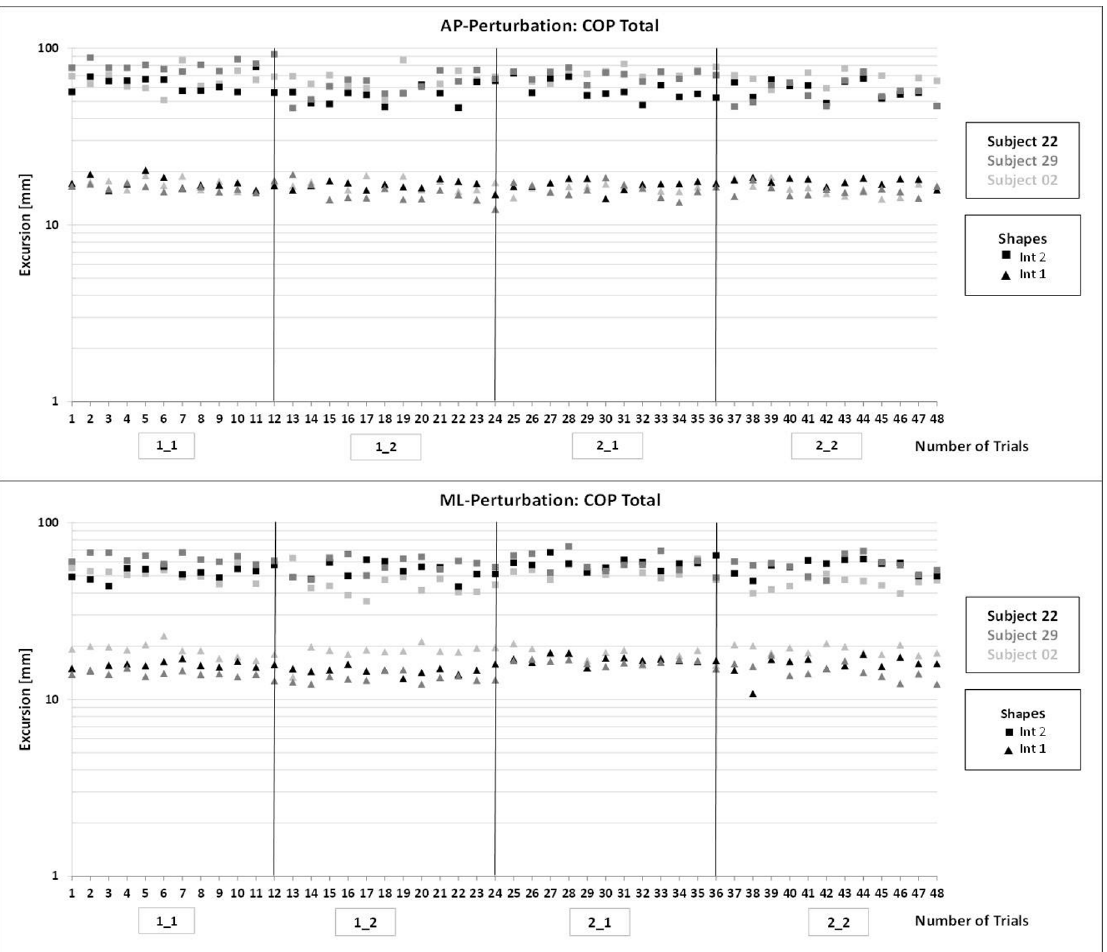
Fig 1. COP Total excursions in both perturbation directions: AP (top), ML (bottom) from six randomly chosen subjects, showing all individual trials (12) for each of the four measurement sessions (1_1, ... , 2_2).